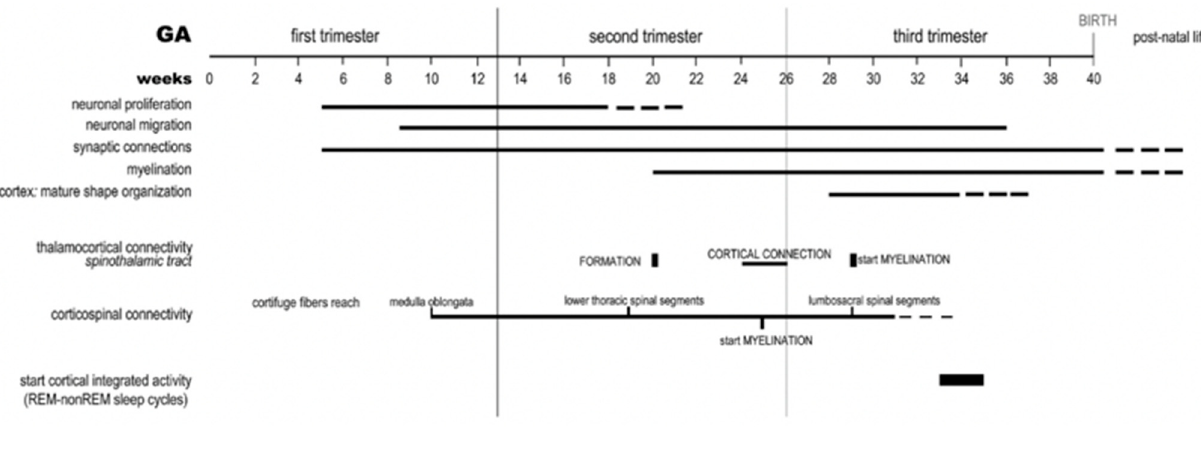
Figure 2. ( A ). Developmental brain processes begin during gestational age (GA) in weeks 2–3 with the formation of the neural tube. At GA week 4, the rostral segment of the neural tube forms the prosencephalic, mesencephalic and romboencephalic vesicles. The prosencephalic vesicle then forms two vesicles that later become the telencephalon and the diencephalon (thalamus, hypothalamus, and other structures). Telencephalic development is depicted in the schematic diagram published by Borsani et al., 2011. [21] Initially, the telencephalic primordium is comprised of proliferating and differentiating neuroepithelial cells (also termed neural stem cells), characterized by interkinetic nuclear migration to form the ventricular zone (VZ). Radial glial cells are particularly prominent and distinctive and undergo early exponential proliferation. Increasing numbers of progenitor/intermediate progenitor cells contribute to the thickness of VZ by week 4. Progenitor neurons include interneurons, which form early and migrate to the marginal (MZ) and intermediate zones (IZ). The MZ eventually forms cortical layer I before the cortical plate (CP) formation as an early MZ (eMZ). A cell-sparse IZ compartment exists before the CP. Radial glial cells and intermediate progenitor cells can be classified into two distinct subpopulations: apical neurons in the VZ with bipolar fibers, and basal types, which delaminate from VZ with unipolar basal fibers. Apical progenitor cells in the VZ and basal progenitor cells in the subventricular zone (SVZ) are considered to be the main source of pyramidal neurons. Around GA week 5, neurogenesis begins at week 5 with neuronal precursors proliferating rapidly within the VZ. The neurons within the first recognizable cortical layer, known as the pre-plate (PP), form the earliest synaptic connections. PP is a transient structure present before the appearance of the CP. Around week 7, the PP cells contribute to the subplate (SP), which remains below the CP after its formation and contains post-migratory pyramidal neurons and interneurons. Accumulation of basal progenitor cells create a distinct new compartment above the VZ, termed the SVZ, where intermediate progenitor cells proliferate. By GA week 8, radially migrating neurons from VZ and SVZ initiate the development of the layered CP forming from inside to outside. Pyramidal neurons eventually migrate outward along the radial glial cells [21]. These neuroembryonic changes influence subsequent brain development during later trimesters ( B ). This timeline depicts neurobiological telecephalic processes with sensory/motor connectivities during human brain maturation. Successive weeks with increasing gestational age (GA) relate to the major events during fetal neural development: neuronal proliferation; neural migration; synaptic connections; myelination; cortex (mature shape organization); thalamocortical connectivity (spinothalamic tract); cortico-spinal connectivity; with the early expression of cortically-integrated activities such as REM-non-REM sleep cycles